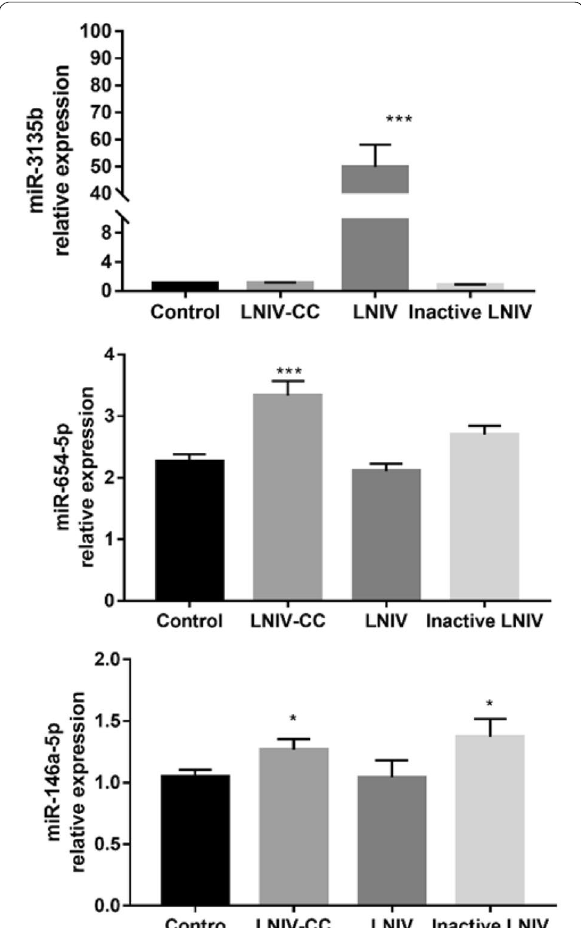
Fig. 6 Expression of selected exosomal miRNAs for each group. Each value represents the mean SEM; * p < 0.05, *** p < 0.001 compared ± with